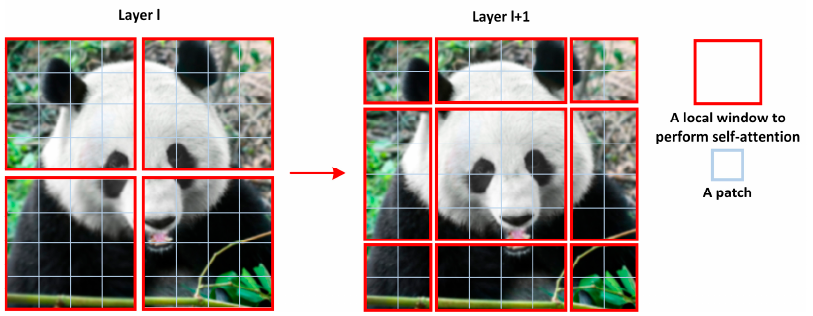
Figure 6. Schematic diagram of sliding window structure.